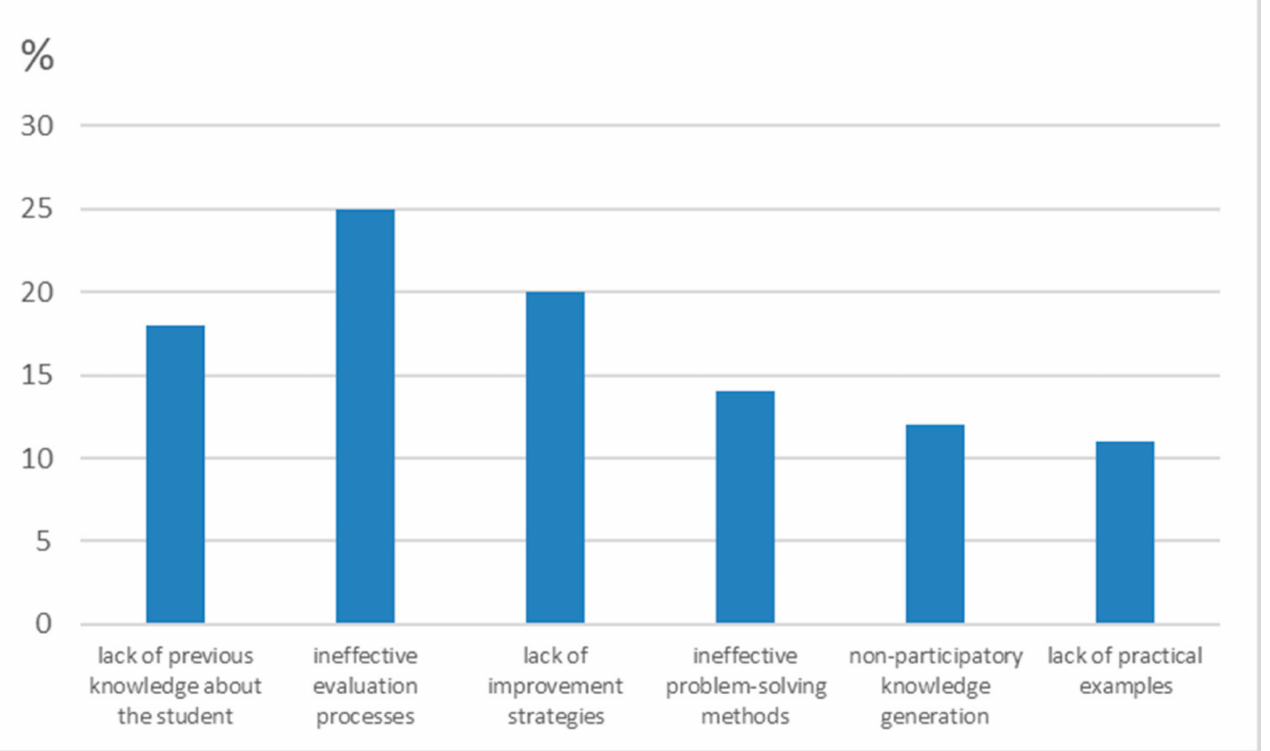
Figure 3. Pedagogical difficulties of